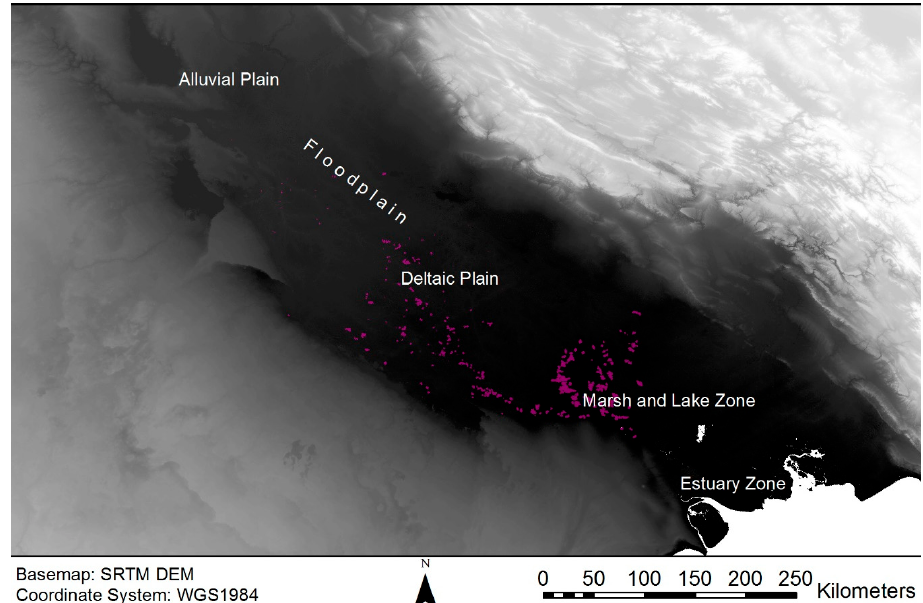
Figure 12. Southern Mesopotamia can be divided into three or four distinctive geographic zones: the alluvial plain, the deltaic plain, the marsh and lake zone (or marsh zone), and the estuary zone. Sometimes, the alluvial plain and deltaic plain are referred to together as the floodplain [37,38]. The newly mapped hollow ways are shown in pink.